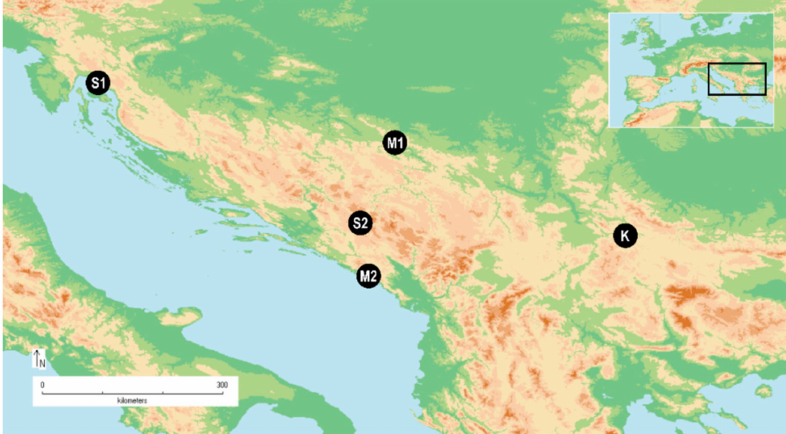
Figure 1. Spatial distribution of studied samples S1: Satureja subspicata subsp. liburnica (Croatia); S2: S. subspicata subsp. subspicata (Montenegro); M1: S. montana (Montenegro) coastal; M2: S. montana (Bosna and Herzegovina) continental; K: S. kitaibelii (Serbia).